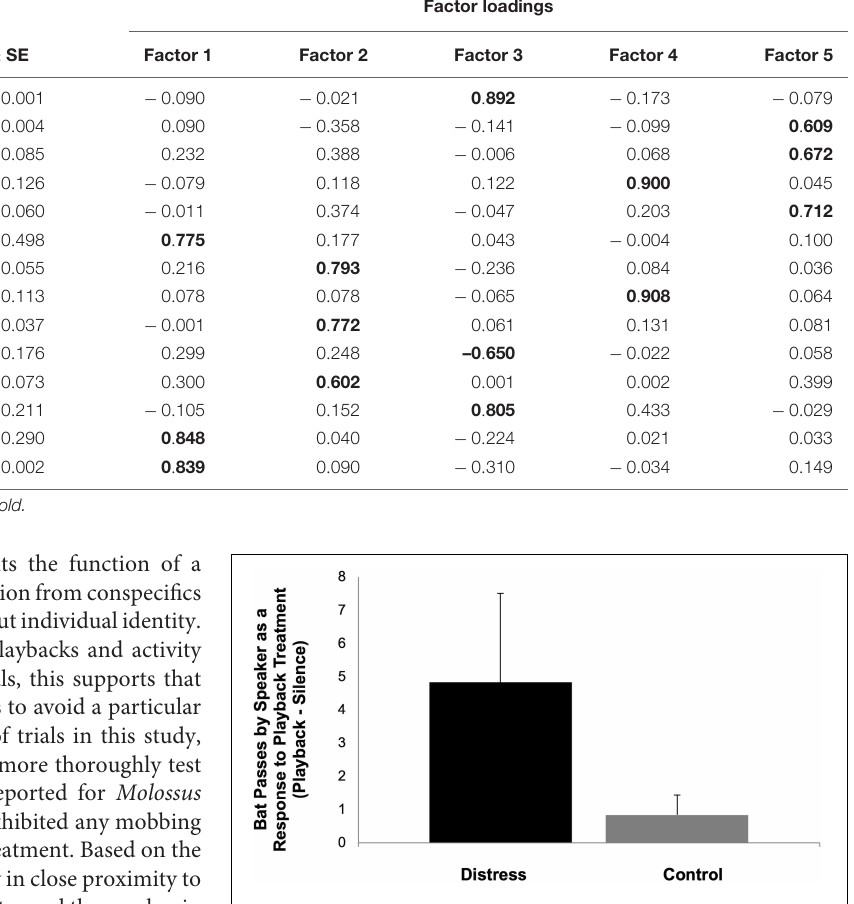
FIGURE 2 | Effect of playback treatment on bat passes near speaker shown as the mean change in responsiveness (passes during playback period—silent period). Error bars represent the standard error of the mean.